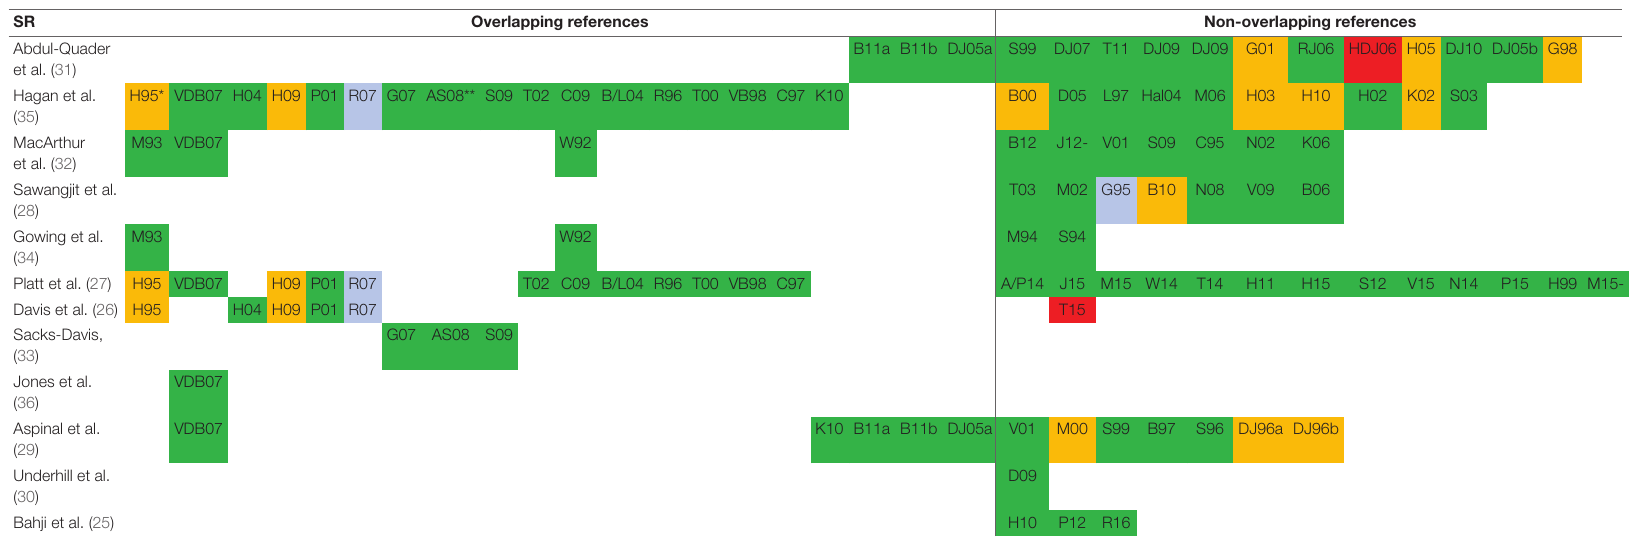
TABLE 2 | Citation